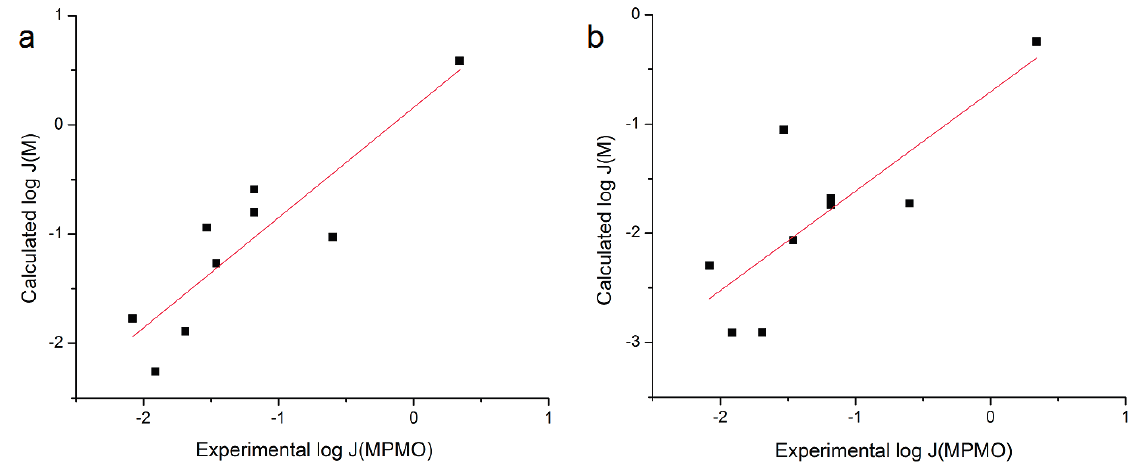
calculated with the coefficients from the Roberts et al. analysis of M using ( a ) S or ( b ) S MPMO 7.4 1.0